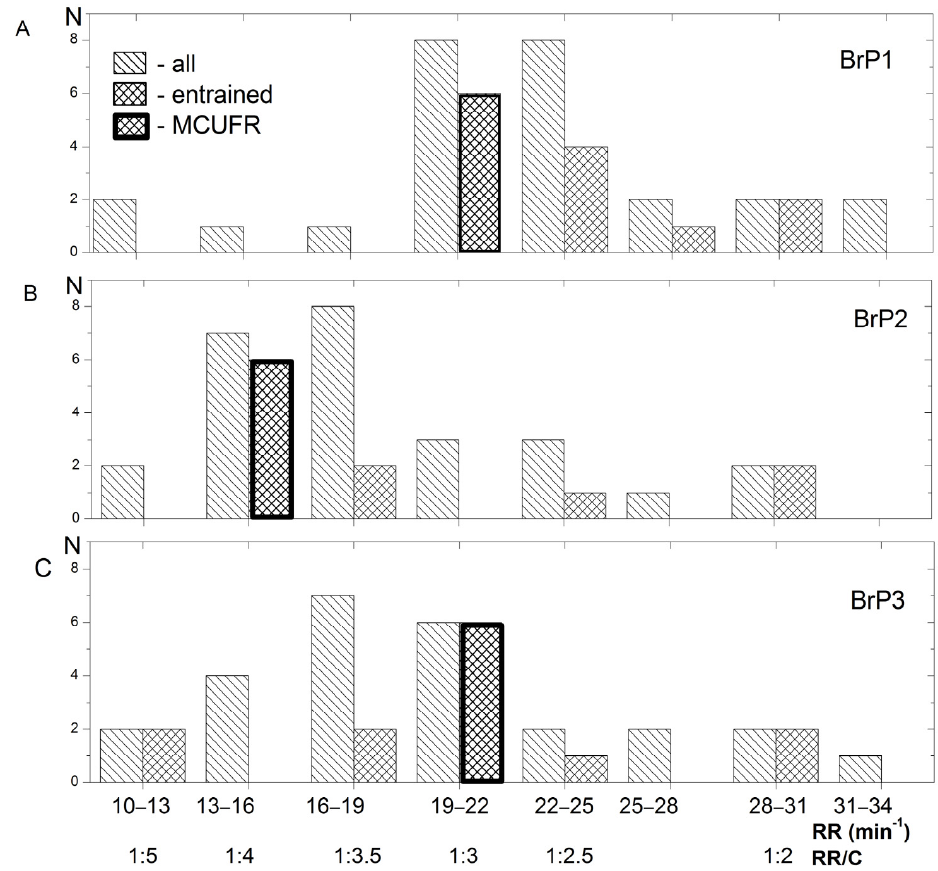
Figure 2. The distribution of the participants according to their RR and entrainment during stationary aerobic cycling. ( A )—spontaneous breathing; ( B )—breathing with phonated exhalation pronouncing “h”; ( C )—breathing with phonated exhalation pronouncing “ss”; N—number of participants; RR— respiratory rate; RR/C—respiratory rate to cadence ratio; MCUFR—most commonly used frequency ratio; BrP1, 2, 3—breathing patterns.